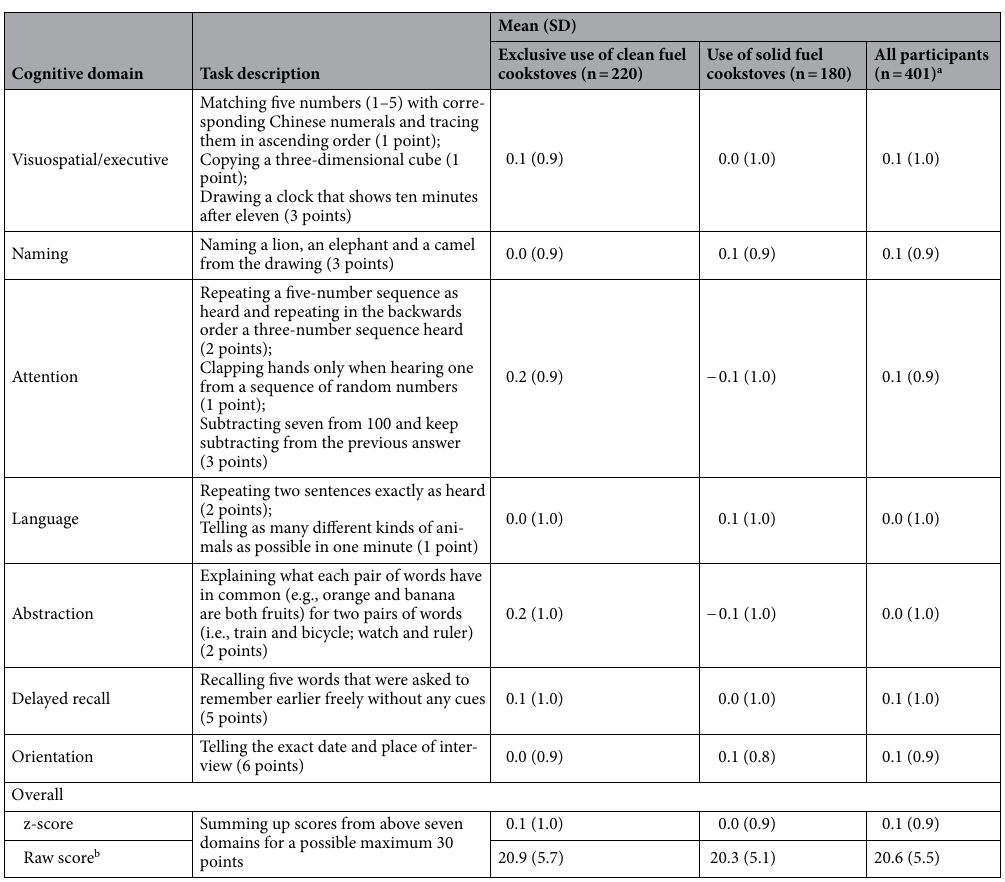
Table 2. Description of cognitive domains and associated tasks in the Montreal Cognitive Assessment (MoCA) survey and participant cognitive scores by current cooking fuel use. All scores are standardized to z scores [mean (SD) = 0 (1)] to allow for comparability across domains. MoCA montreal cognitive assessment. a Includes 1 participant with measured personal exposure to air pollution but missing fuel use data. b We did not add 1 point for participants with < 12 years of education as is standard for cognitive screening 16 and instead adjusted for educational attainment in the statistical